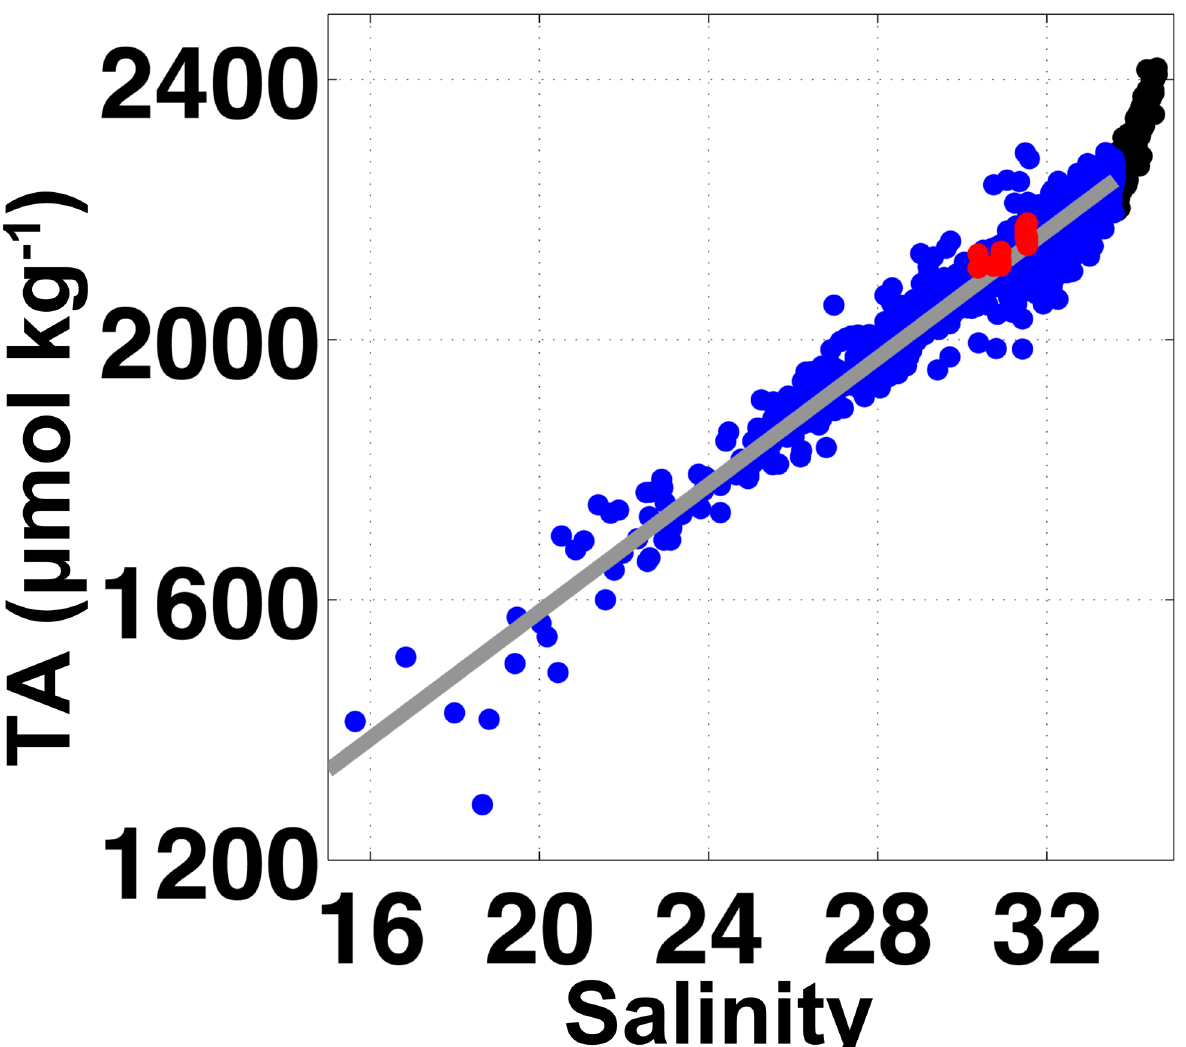
Fig 3. Relationship between total alkalinity (TA; μ mol kg -1 ) and salinity in the northern Gulf of Alaska calculated using the data described in Fig 1. The linear fit (gray line) for these data is: TA = 48.7709 * S + 606.23 μ mol kg -1 (r 2 = 0.94, root mean square error = 17.21 μ mol kg -1 ). This fit was calculated using the MathWorks MATLAB robust linear regression algorithm with only salinity data < 33.6 (blue dots). Measurements above this salinity range are deep samples collected over the outer continental shelf that have a steeper TA-salinity relationship (black dots). Twenty-three validation TA measurements (S1 Table) were made and are shown here as red